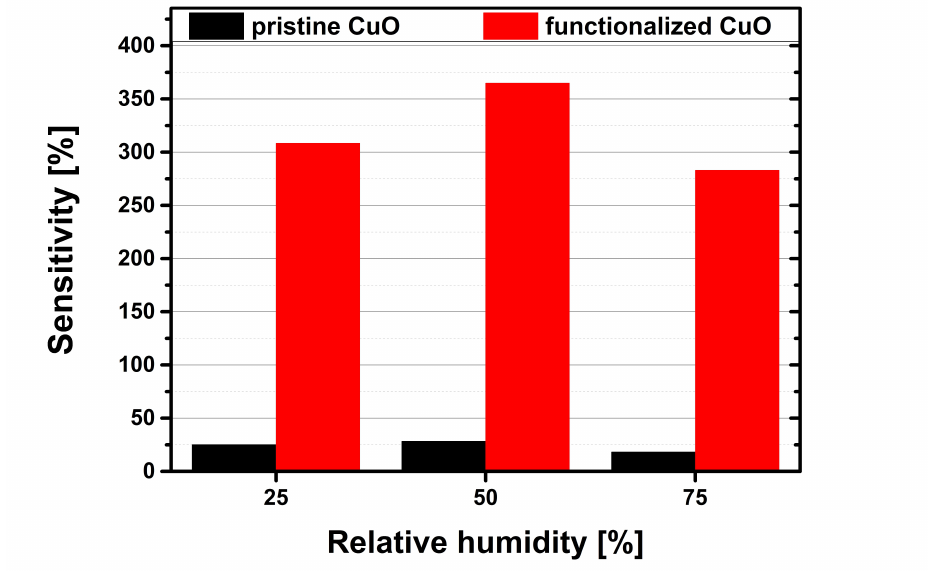
Figure 9. Comparison of the pristine (black bars) and the Au-NPs functionalized (red bars) gas sensors sensitivities towards a 2000 ppm CO 2 gas pulse at relative humidity levels of 25%, 50% and 75% at an operation temperature of 300 ◦